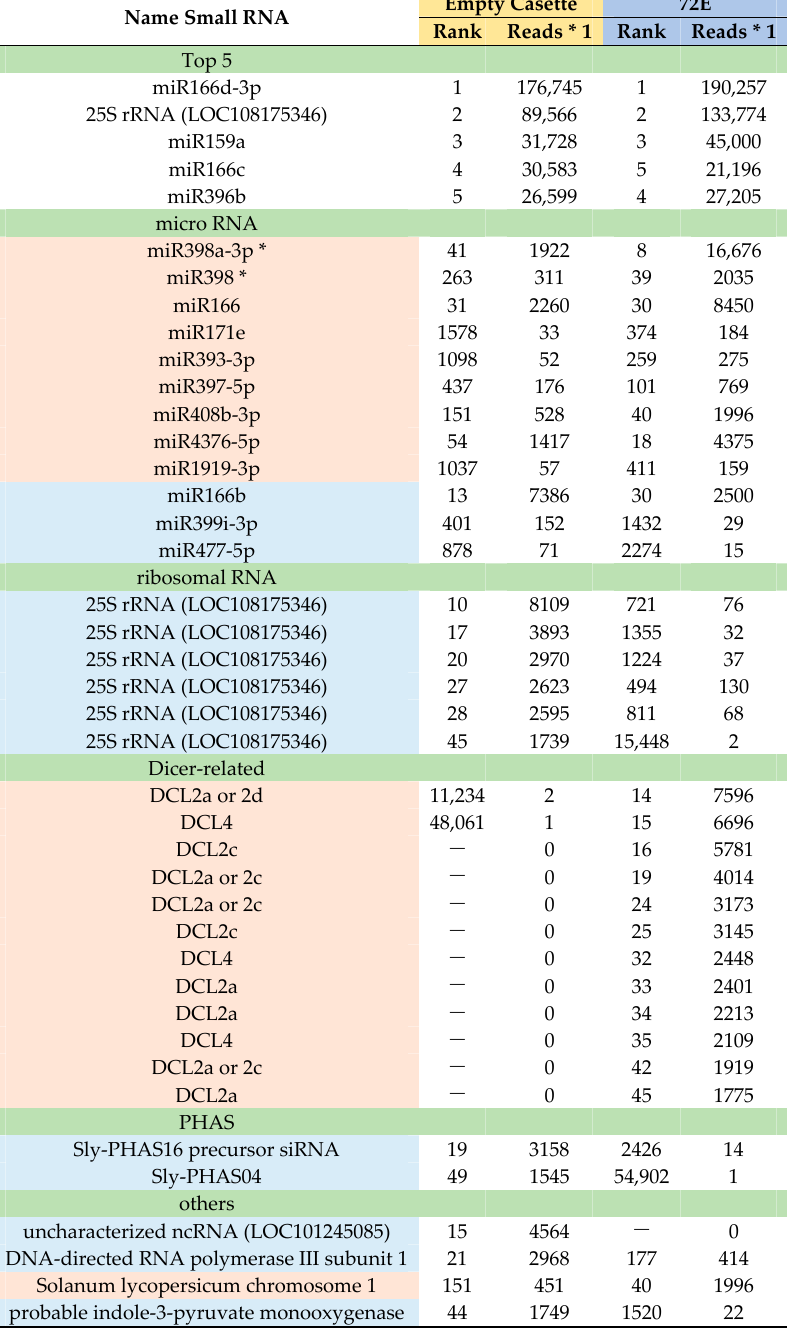
Viruses 2018 , 10 , x 14 of 26 Table 1. Changes in tomato sRNA levels in lines potato spindle tuber viroid (PSTVd) -72E and -EC.